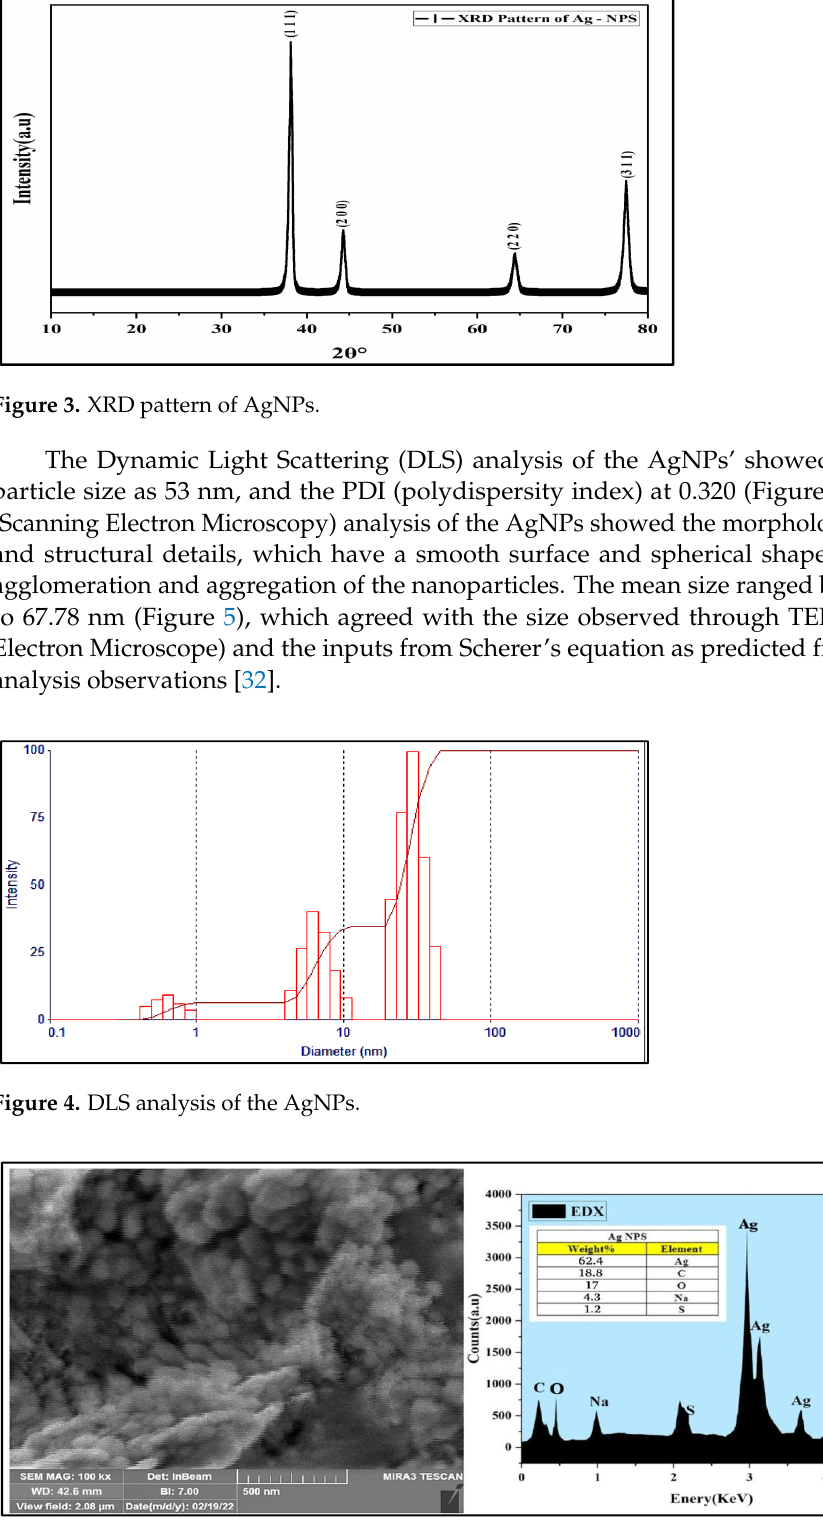
Figure 2. FT-IR absorption spectrum of AgNPs.